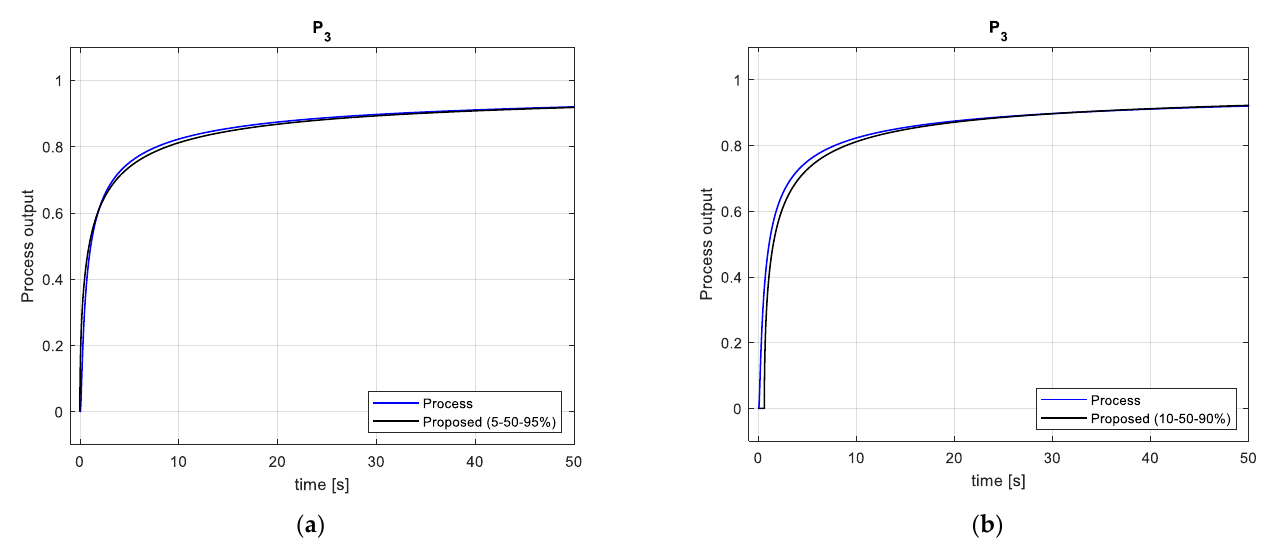
Figure 21. FFOPDT model step response using the proposed identification method for process P 3 and process reaction curve: ( a ) Symmetrical set of points (5-50-95%); ( b ) Symmetrical set of points (10-50-90%).